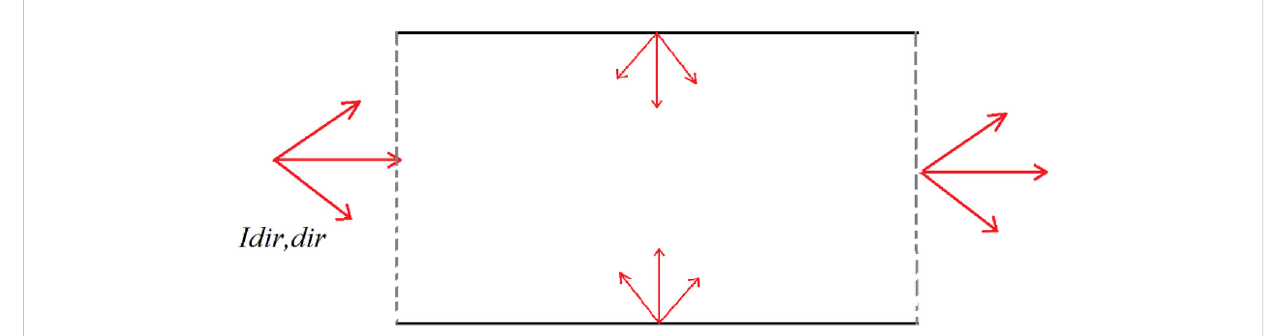
FIGURE 6 Schematic diagram of diffuse-to-diffuse radiation.